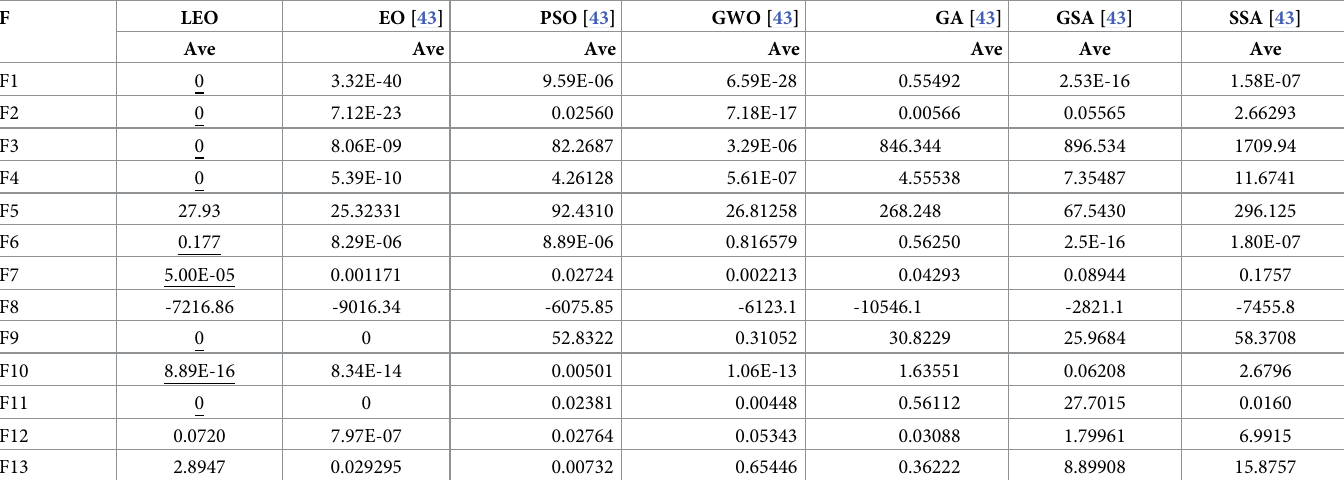
Table 3. Average result of benchmark functions.